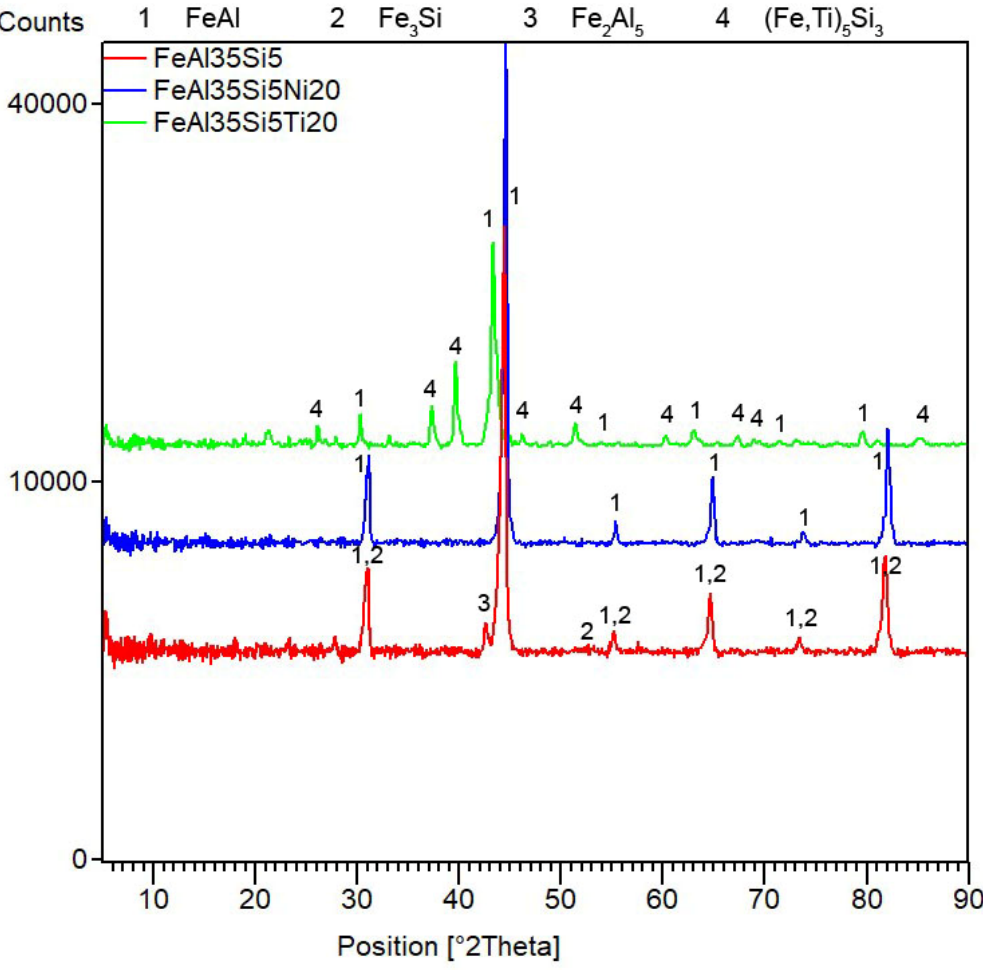
Figure 1. X-ray diffraction analysis (XRD) patterns of the tested bulk alloys that were produced by mechanical alloying and spark plasma sintering.